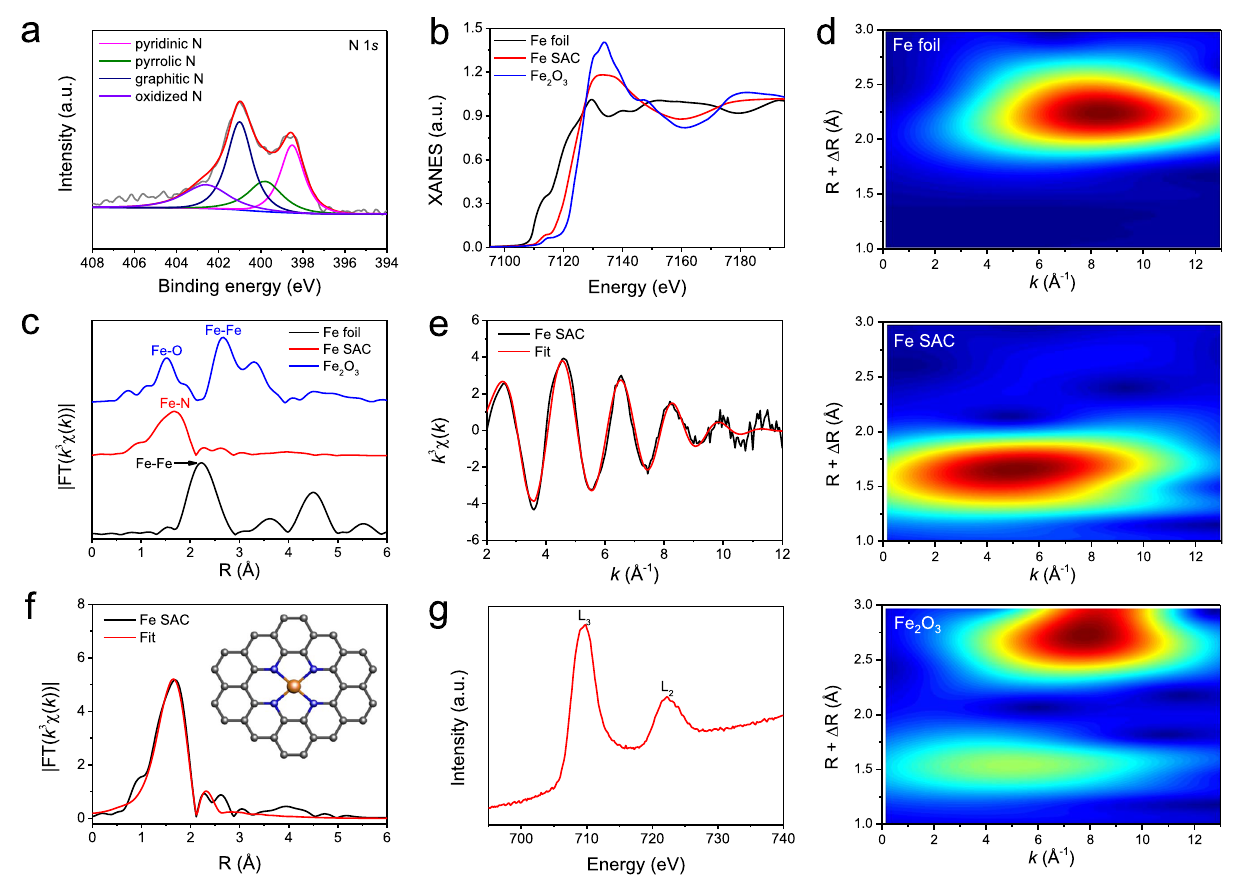
Fig. 2 Structural analysis of Fe SAC. a High-resolution N 1 s of the Fe SAC. b XANES spectra at the Fe K-edge of the Fe SAC, referenced Fe foil and Fe 2 O 3 . c FT k 3 -weighted χ ( k )-function of the EXAFS spectra at Fe K-edge. d WT of the Fe K-edge. Fitting results of the EXAFS spectra of Fe SAC at e k-space and f R space. Inset: Schematic model of Fe SAC: Fe (yellow), N (blue), and C (gray). g XANES spectrum at Fe L-edge of Fe